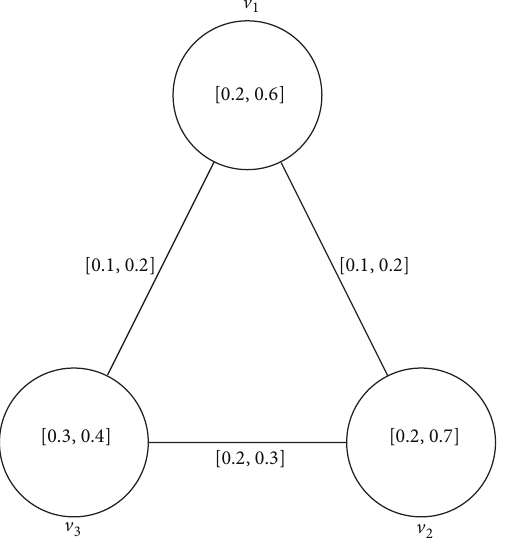
Figure 2: Irregular interval-valued fuzzy graph.